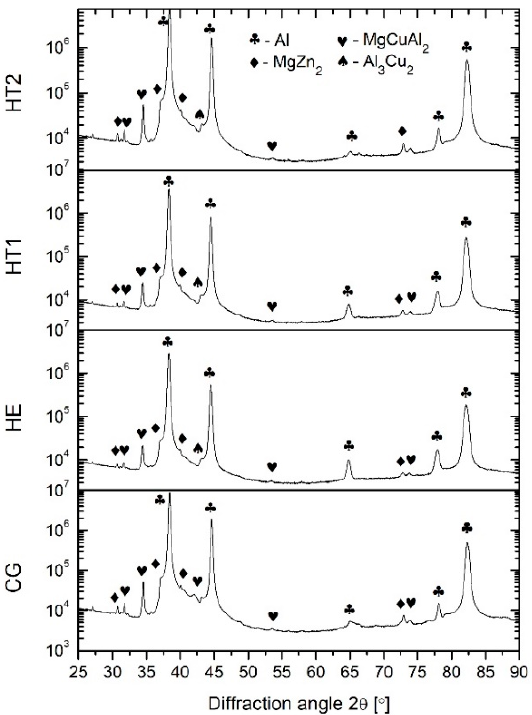
Figure 3. XRD patterns of examined samples (PDF no. of identified phases: PDF 00-004-0787—Al, PDF 01-073-5874—MgCuAl 2 , PDF 00-034-0457—MgZn 2 , PDF 01-071-5716—Al 3 Cu 2 ).